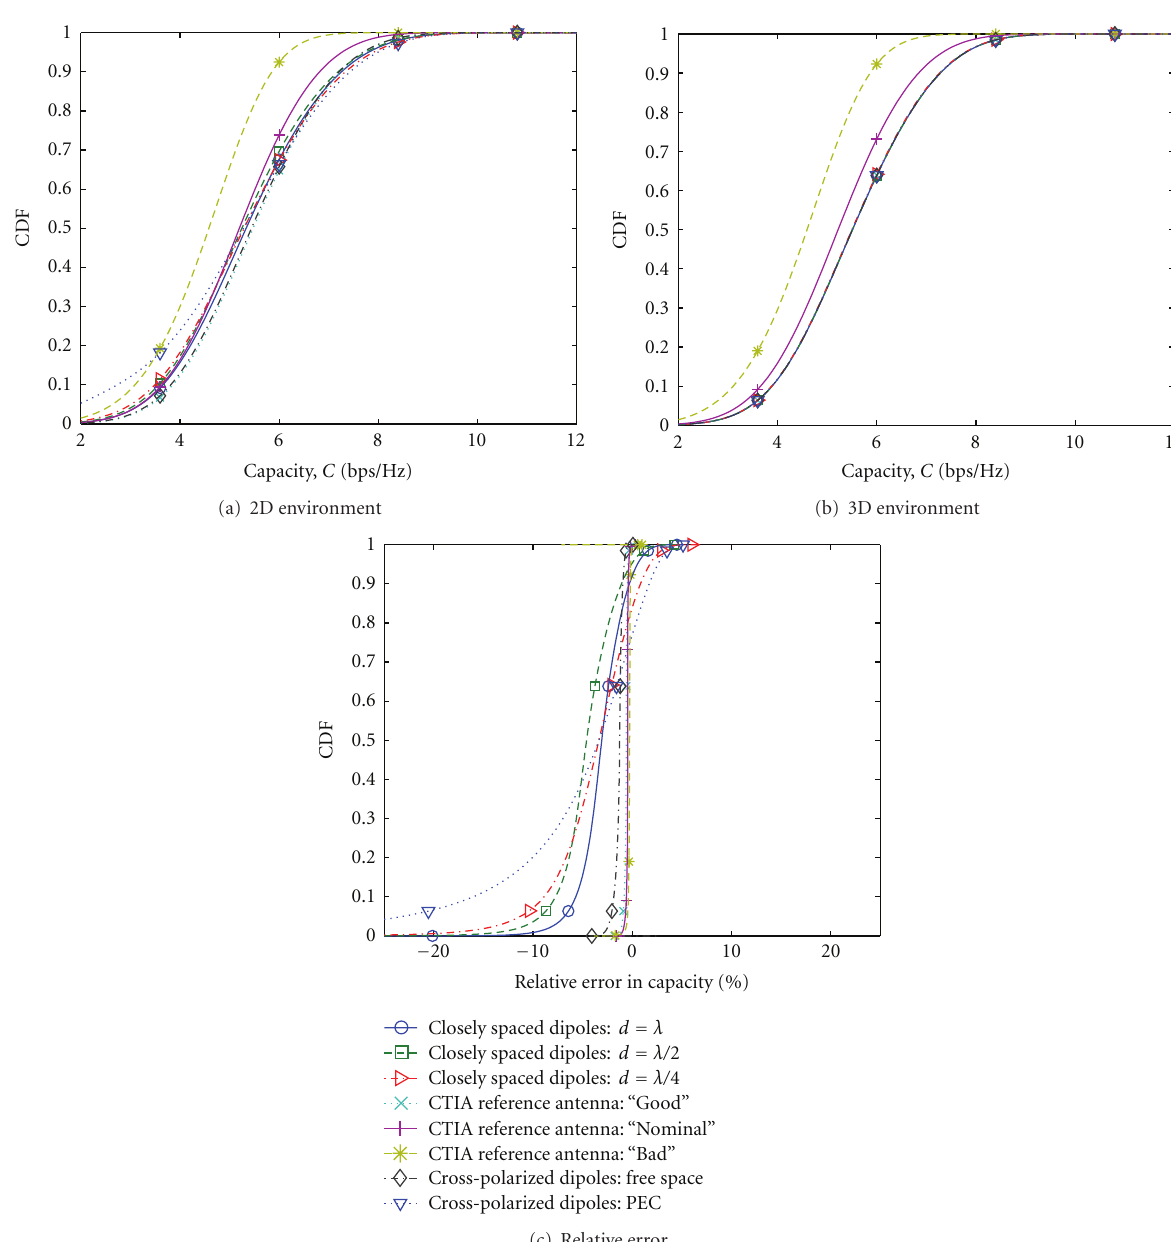
Figure 4: Comparison of the capacity CDFs for the di ff erent AUTs in statistically isotropic environments at multiple orientations: (a) orientation-combined capacity CDFs for the 2D environment, (b) orientation-independent capacity CDFs for the 3D environment, (c) relative error in the 2D environment’s orientation-combined capacity CDFs with respect to the 3D environment’s orientation-independent capacity CDFs. The center plot’s legend applies to all three